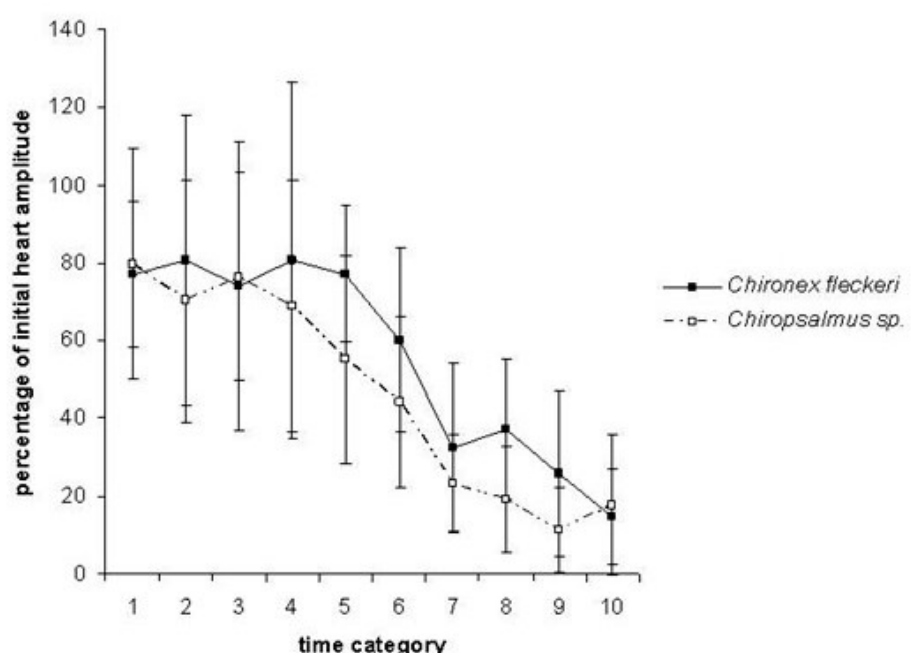
Figure 3: Percentage of initial heart amplitude over time category for animals envenomed with Chironex fleckeri and Chiropsalmus sp. venom (95% confidence limits displayed).